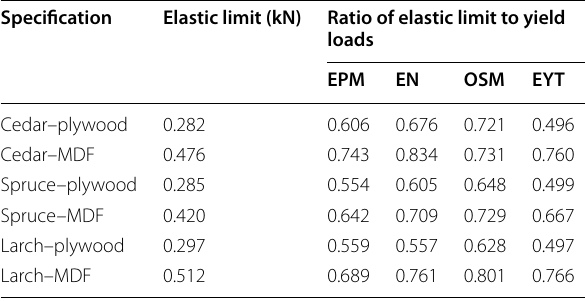
Table 5 Elastic limit and the ratio of the elastic limit to the yield loads obtained using engineering techniques Specification